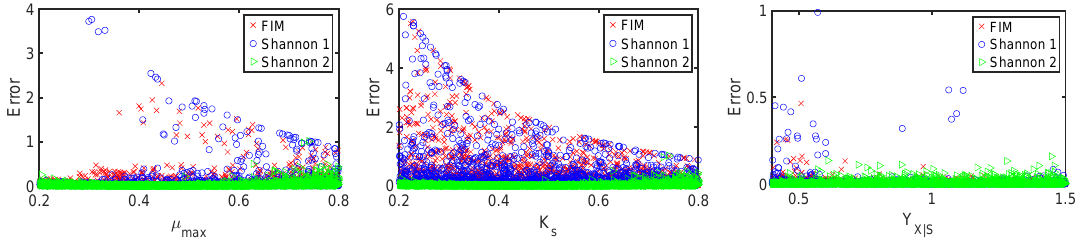
Figure 11. Error of the parameter estimates of µ max , K S and Y X / S . 2000 MC simulations are shown for the classical E ∗ -design and Shannon-entropy-based design with w = [ 1,1,0,1 ] , and w = [ 1000,1,0,0.1 ]